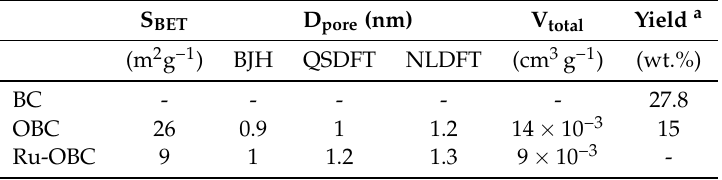
Table 2. Nitrogen Adsorption-Desorption Analysis.